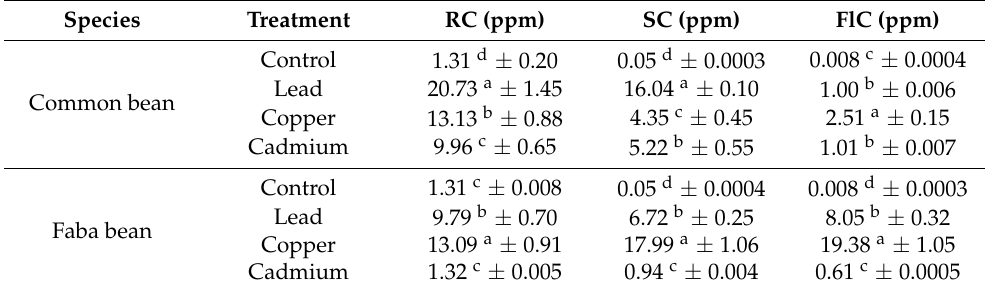
Table 5. The HM concentrations in roots, shoots and flowers in common bean and faba bean at the flowering stage.